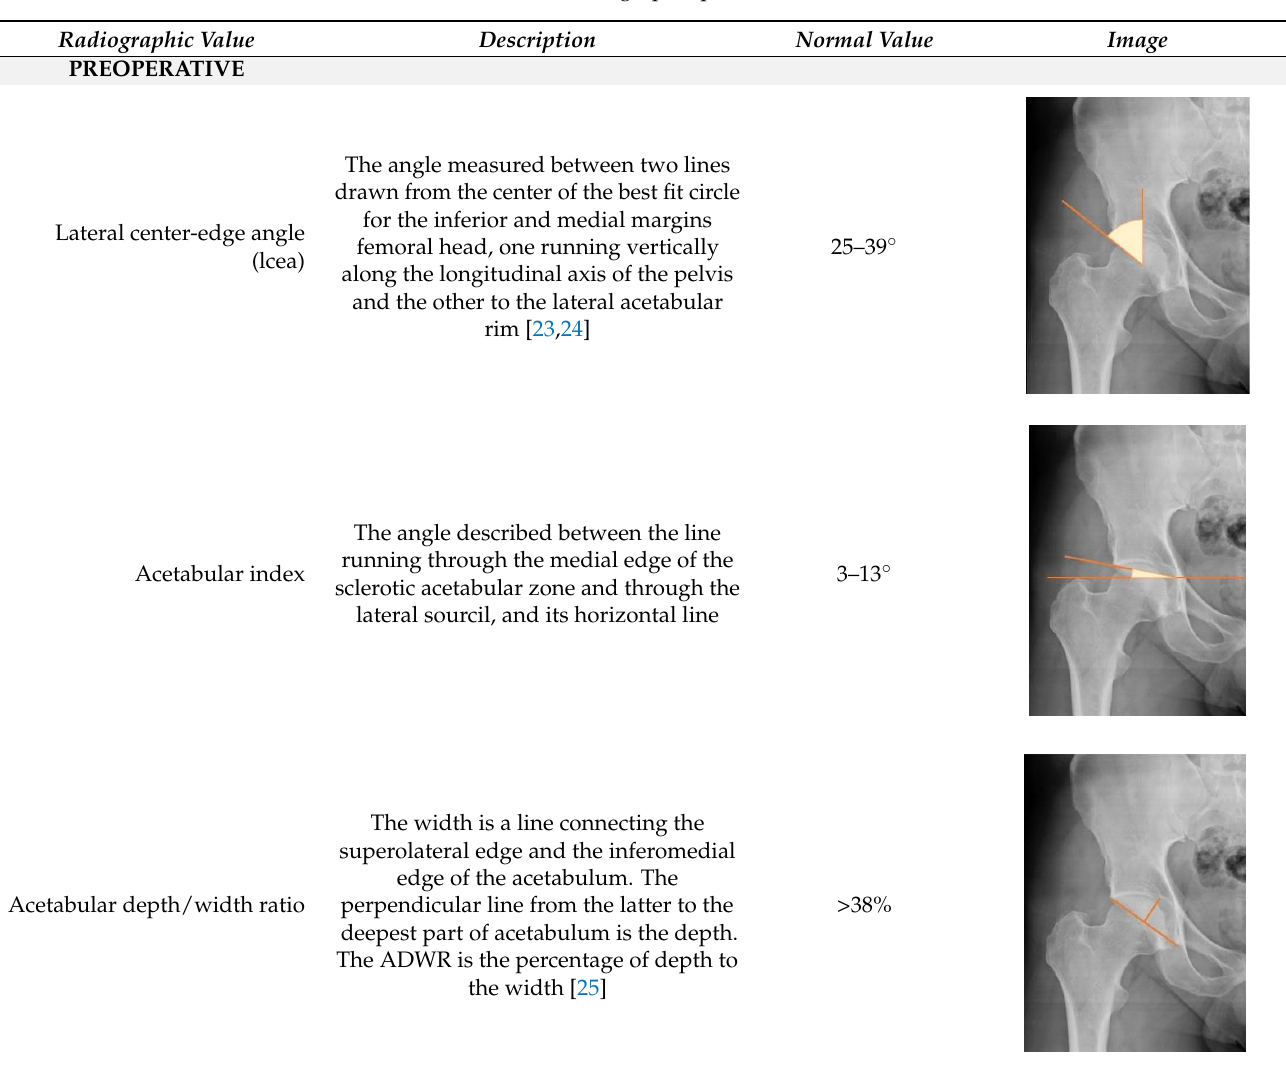
Table 1. Radiographic parameters.